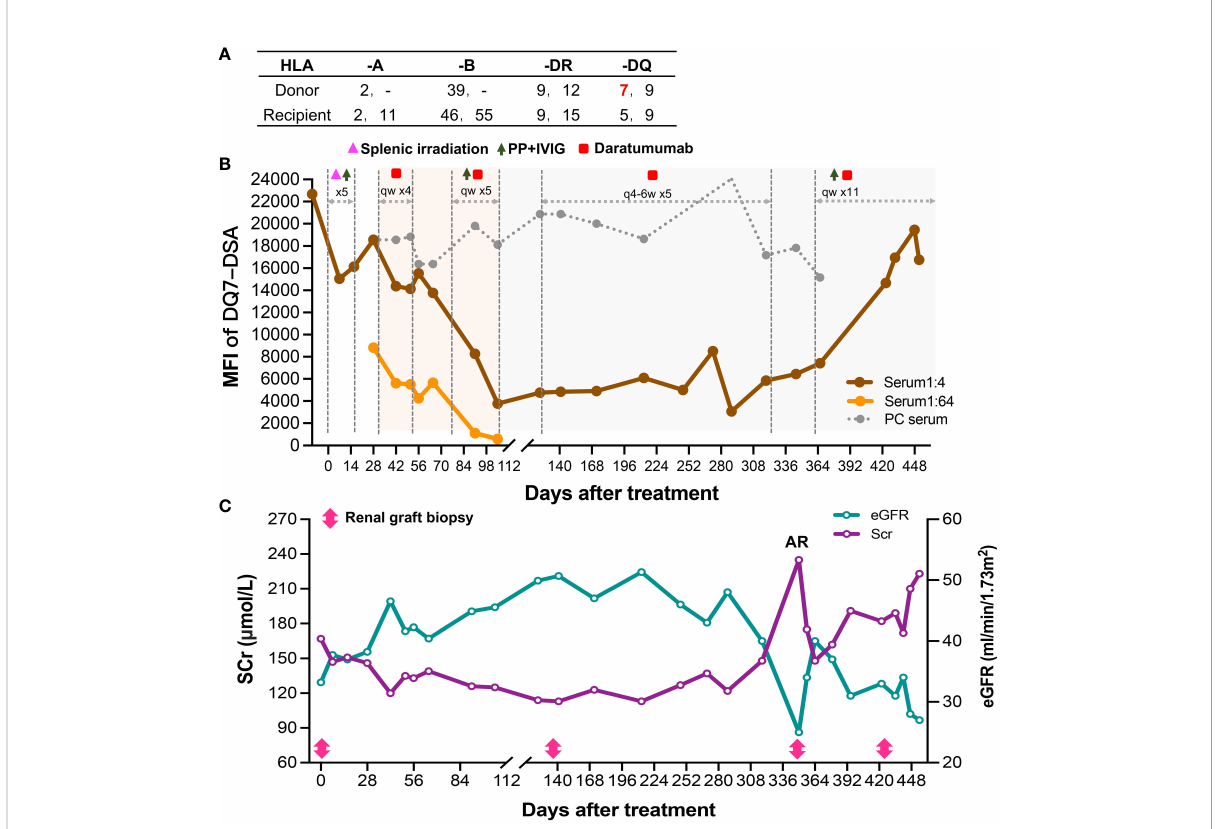
FIGURE 2 Course of Patient 2 ’ s DSA and renal function after the diagnosis of late active AMR. (A) HLA phenotype results for the recipient and his donor. (B) Changes in MFI values of the anti-DQ7 DSA (1:4 or 1:64-diluted serum and positive control serum) during the treatment. (C) Changes in serum creatinine and eGFR levels after the diagnosis and treatment of late active